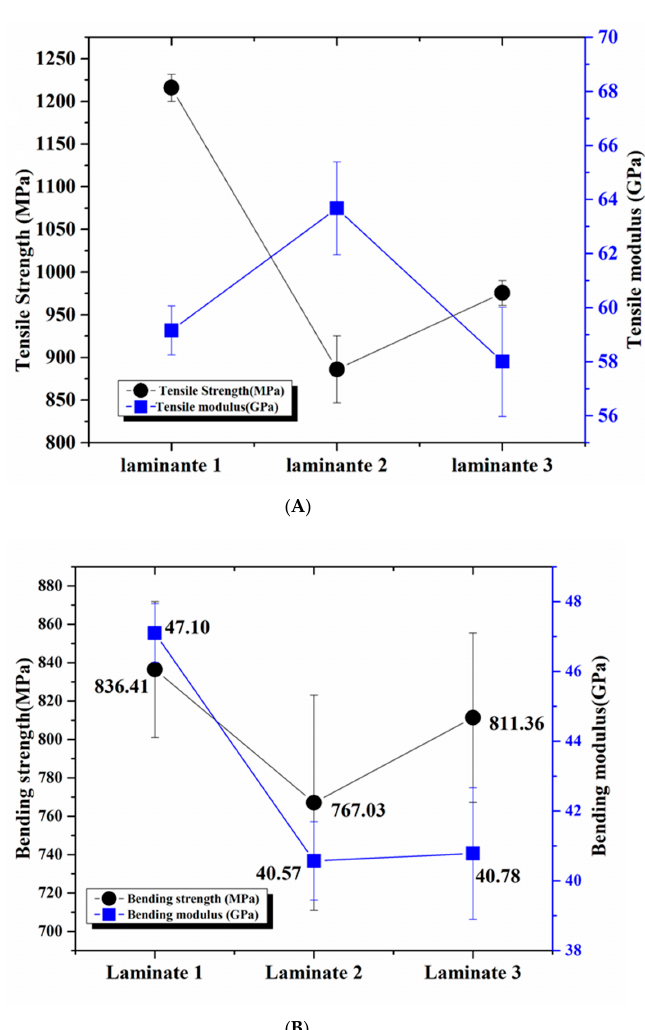
Figure 9. Tensile property ( A ) and bending property ( B ) curves of different samples.